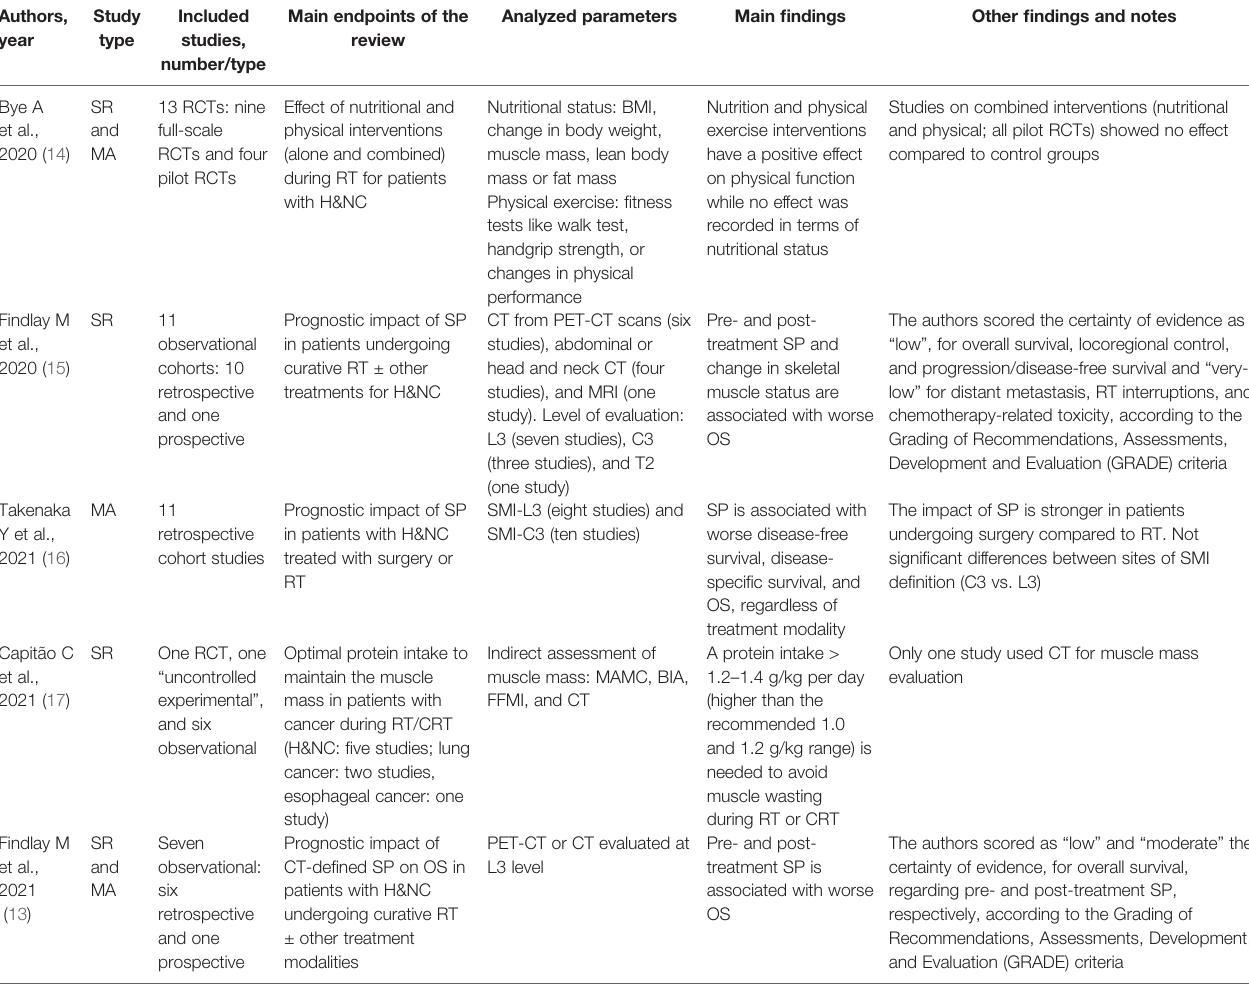
TABLE 1 | Characteristics and results of the included